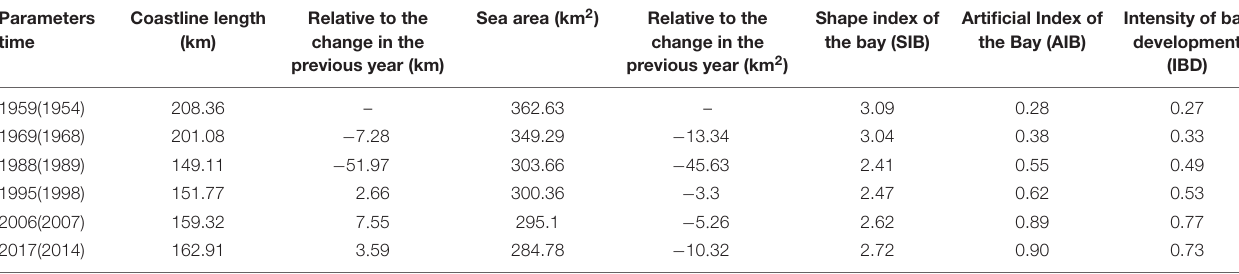
TABLE 5 | The variation of parameters from 1954 to 2017 in Quanzhou Bay. Parameters